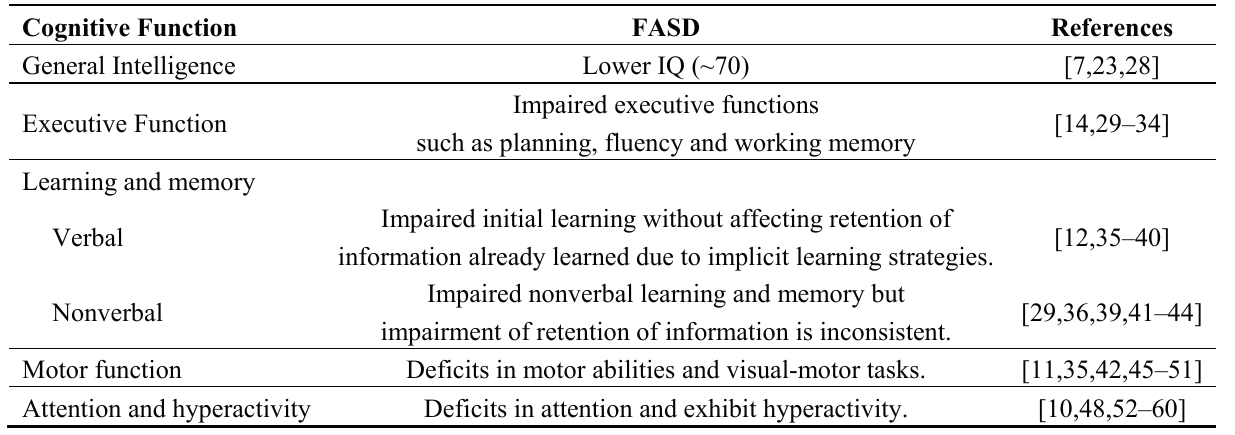
Table 1. Summary of neuropsychological abnormalities found in individuals with fetal alcohol spectrum disorders (FASD) when compared to typically developing